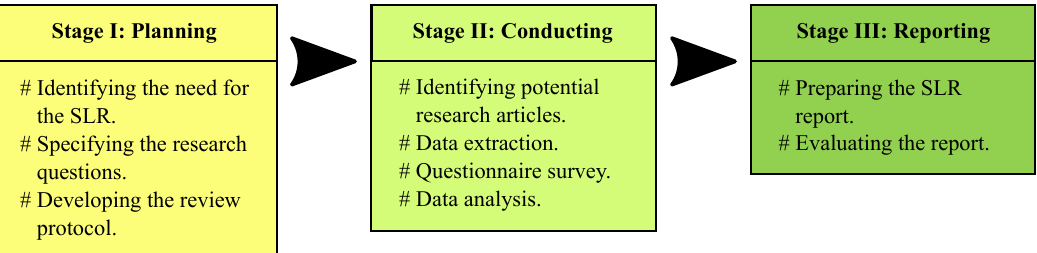
Figure 4. SLR methodology stages following the guidelines from Kitchenham and Charters